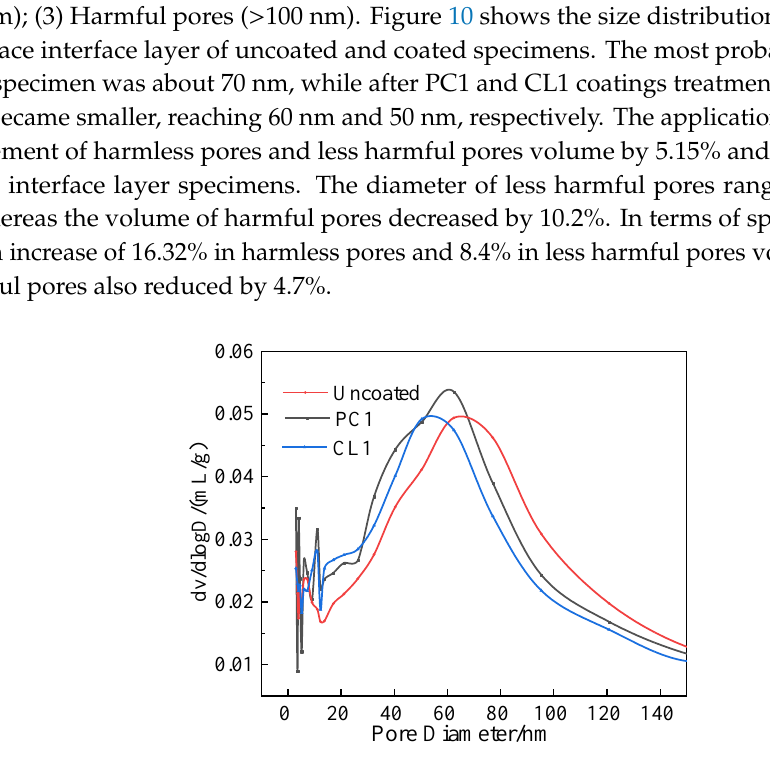
Figure 10. E ff ect of coatings on the pore sizedistribution of Figure 10. Effect of coatings on the pore sizedistribution of specimens. Figure 10. Effect of coatings on the pore sizedistribution of specimens.